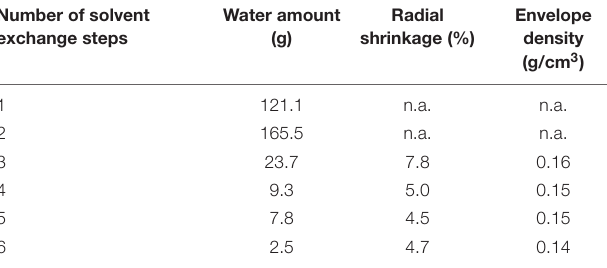
TABLE 2 | Properties of static washed samples and corresponding water